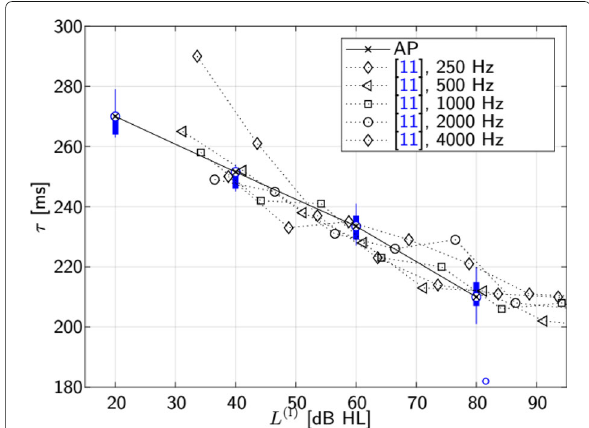
Fig. 7 Box-and-whisker plot of the measured reaction time overlayed by a line graph showing the median reaction time ( τ 0 = 190